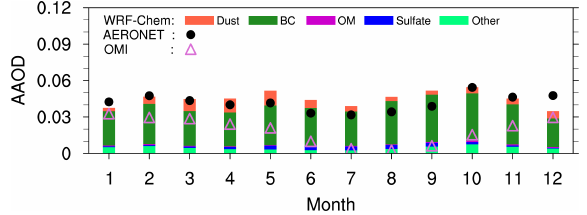
Figure 10. Monthly AAOD from the retrievals of AERONET and OMI and the corresponding WRF-Chem simulation averaged for the period 2010–2014 over the East Asia sites as shown in Fig.